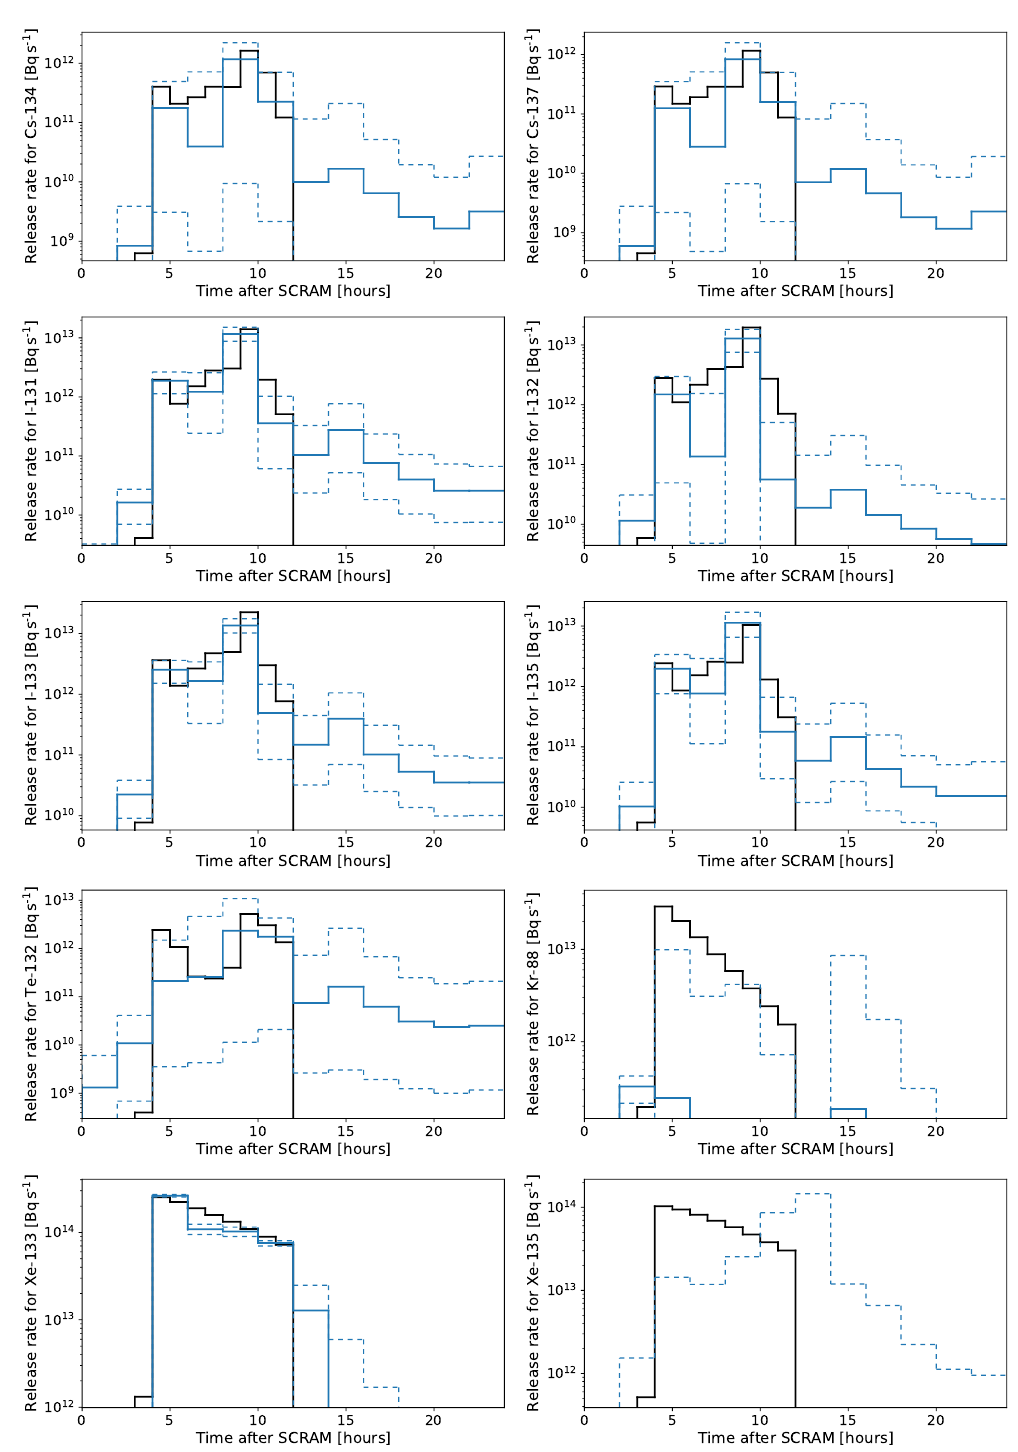
Figure 2. Release rates for each radionuclide in each 2-h time bin. The solid blue lines show the medians of the marginal distributions, while the dashed blue lines show the 10th and 90th percentiles. For comparison, the solid black lines show the true release profile. To focus on the release rates of high magnitude, we have set the minimum value on the y -axis to 10% of the lowest true release rate. Thus, predicted release rates below this limit are not shown in the plot, e.g., the predicted release rate of Xe-135 only shows the 90th percentile, while both the 10th percentile and the median are below the axis